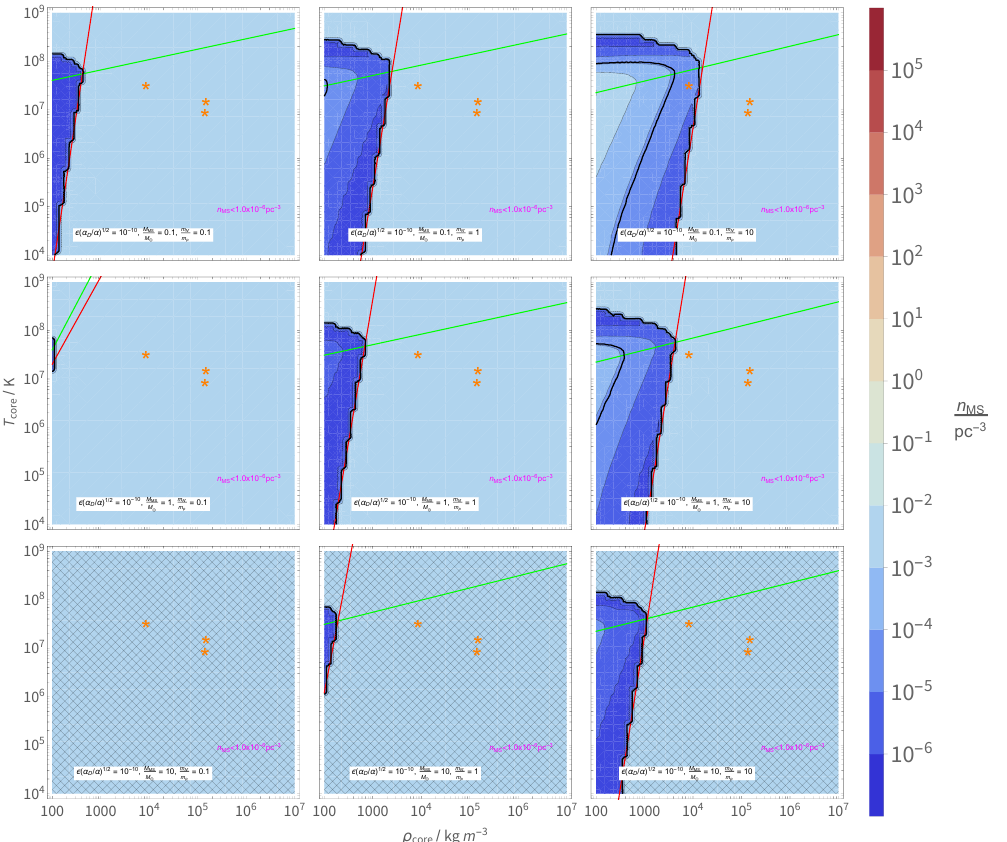
Figure 10. Gaia constraints on the local Mirror Star number density n MS as a function of core density and core temperature, for (cid:15) p α = 10 − 10 . From top to bottom, the panels assume D /α em that mirror red dwarfs have mass M = 0 . 1 , 1 , 10 and from left to right assume nuclear MS /M (cid:12) constituent masses m = 0 . 1 , 1 , 10 . The hatched region indicates where the Gaia constraints N /m p are weaker than the requirement that ρ is smaller than the locally measured DM mass density MS ρ DM = 0 . 5 GeV / cm − 3 . To the left (right) of the red line, the optically thin (thick) region provides the strongest constraint. Above the green line, converted X-rays from the mirror star core contribute to heating the SM nugget. The solid black contour corresponds to ρ = 0 . 01 ρ . The three MS DM orange asterisks indicate ( ρ ) of a 0 . 2 , 1 and 10 solar mass SM star (in order of increasing core , T core core temperature) for